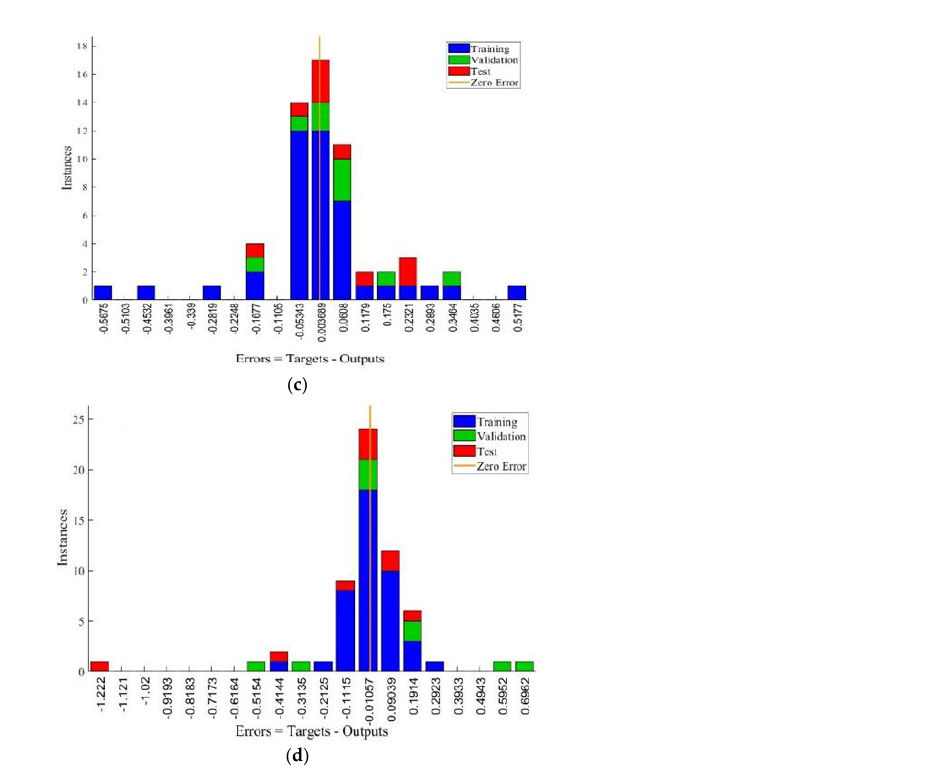
Figure 4. ( a ) Error histogram of ANN model without heat generation. ( b ) Error histogram of ANN model with heat generation. ( c ) Error histogram of ANN model without radiation effect. ( d ) Error histogram of ANN model with radiation effect.